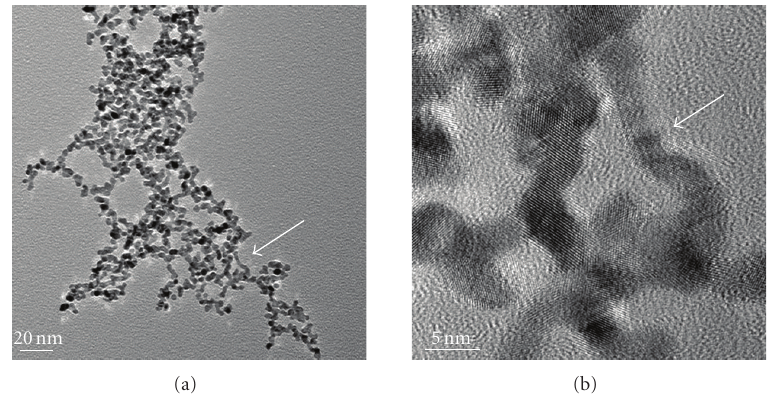
Figure 2: TEM (a) and HRTEM (b) of Pt nanoparticles in aqueous colloid; the arrows denote the same location.